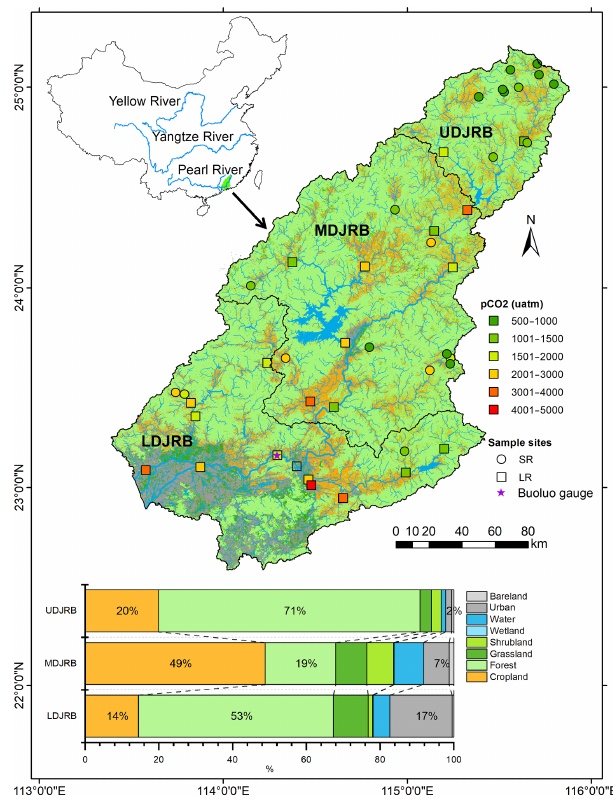
Figure 1. Sample sites and land cover in the DJRB. Yearly average p CO 2 at each sample site was displayed. Based on the land cover dataset FROM-GLC10 (http://data.ess.tsinghua.edu.cn, last access: 17 September